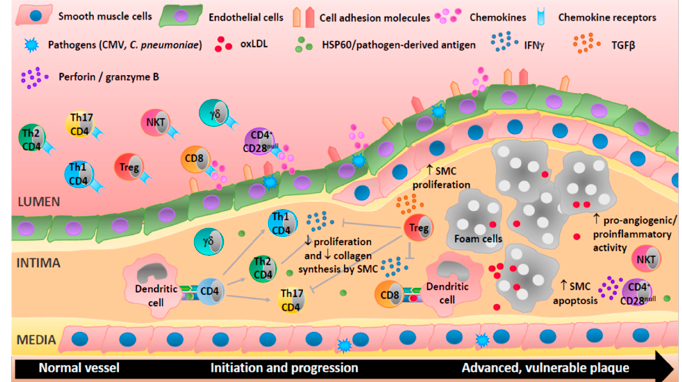
Figure 2. Adaptive immune cells are involved in all stages of human atherosclerosis. Endothelial cells activation upregulates cell adhesion molecules and secretion of chemokines and so directs T-cells to the site of inflammation. T helper (Th)1 cells produce interferon- γ (IFN γ ), a proatherogenic cytokine able to activate macrophages, inhibit proliferation, and reduce collagen production by smooth muscle cells. Th2 cells produce interleukin (IL)-4 and may be atheroprotective as they can inhibit Th1 cells. CD4 + CD28 null T-cells may damage cells in the vascular wall via the release of perforin and granzyme B. CD8 + T-cells may be proatherogenic via the production of IFN γ or protective by reducing macrophage content in the plaque. Treg cells can suppress Th1 and Th17 responses and increase smooth muscle cell proliferation through the secretion of cytokines (e.g., transforming growth factor (TGF)- β ). Natural killer (NK)T cells exhibit proangiogenic and proinflammatory activities suggesting an involvement in plaque destabilization. Th17 and γδ T-cells are present in lesions but their roles are not well characterized. T-cells can be activated by heat shock proteins (e.g., HSP60), oxidized lipoproteins (oxLDL), or antigens derived from pathogens (e.g., cytomegalovirus (CMV) and Chlamydia pneumoniae ( C. pneumoniae